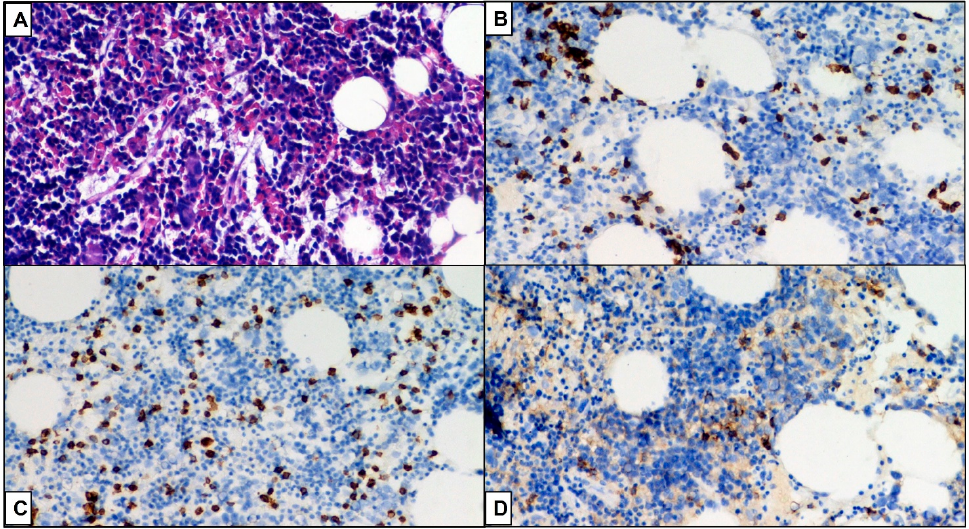
Figure 2. Hypercellular bone marrow with erythroid hyperplasia (>50% of total BM cells). ( A ) Hematoxylin-eosin, original magnification 100 × . ( B ) Immunoreactivity for CD3, immunohistochemistry, 20 × . ( C ) Immunoreactivity for CD8, immunohistochemistry, 100 × . ( D ) Immunoreactivity for CD4, immunohistochemistry, 100 × .